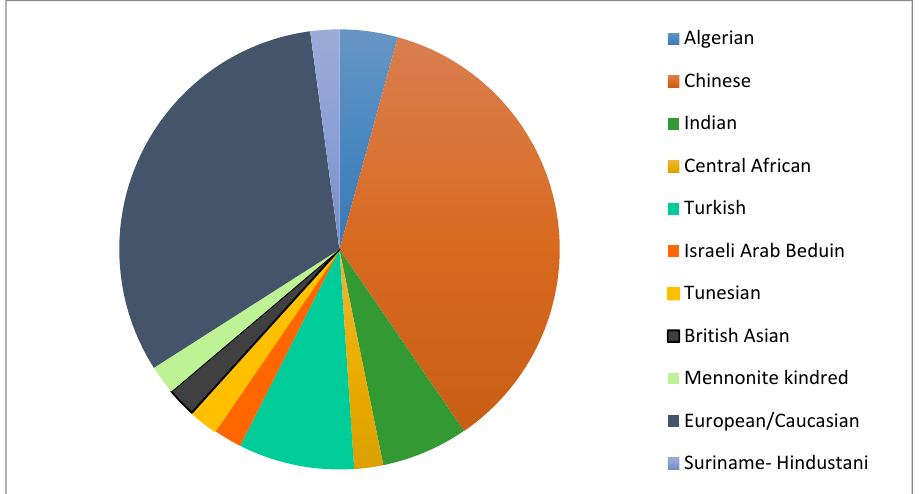
Figure 1. Ethnic/geographic background of 47 families affected with GSD VI.